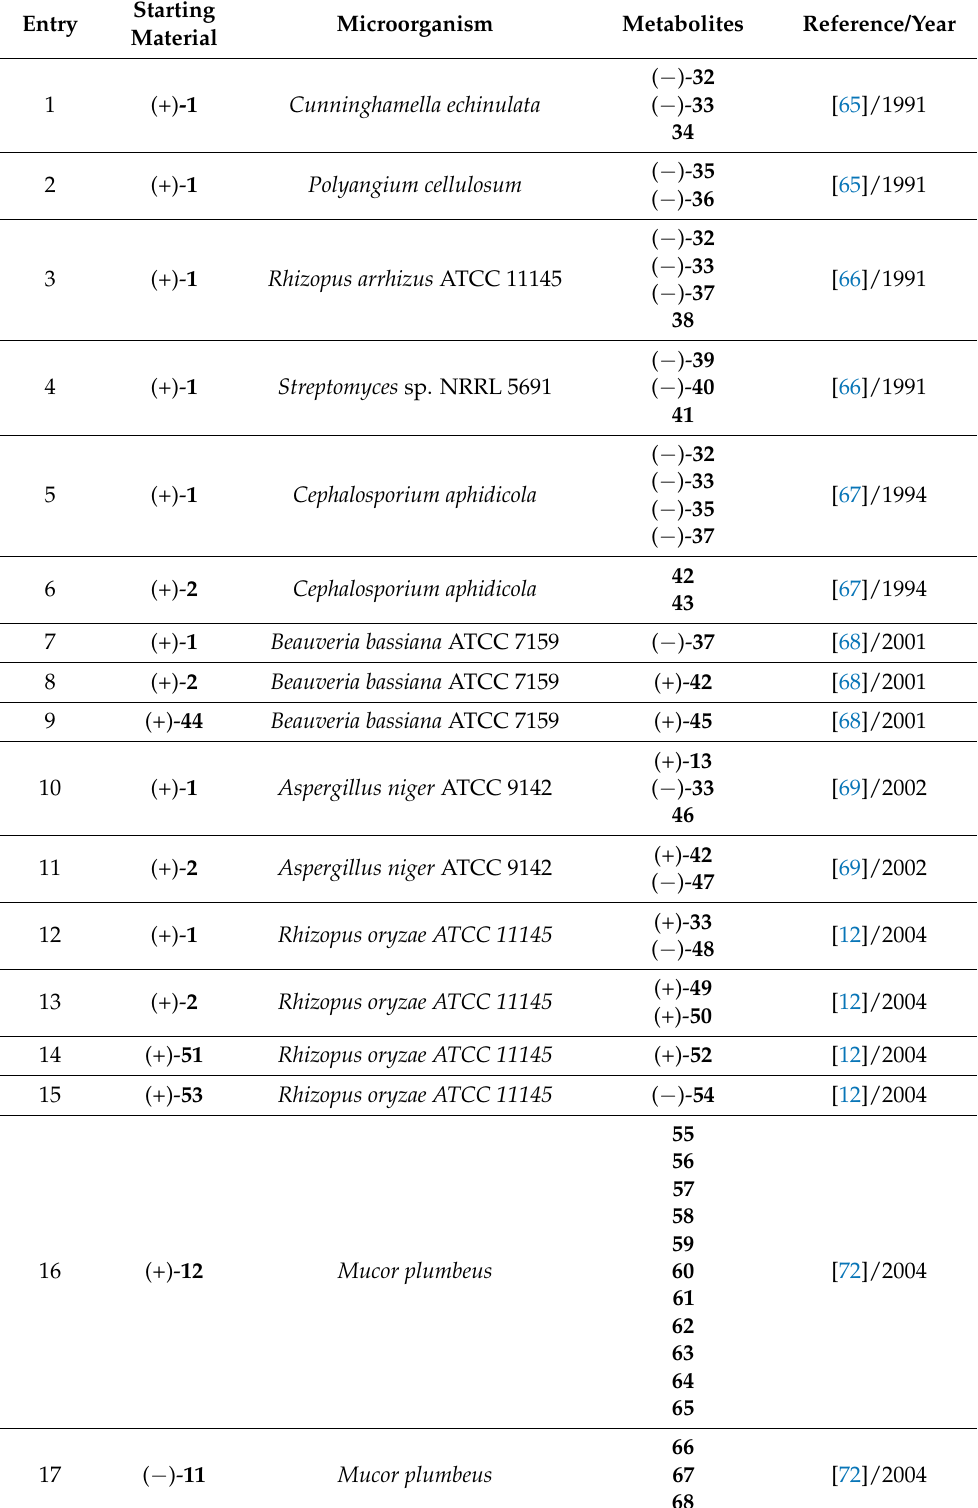
Table 5. Metabolites obtained by the action of various microorganisms on stemodane diterpenoids and